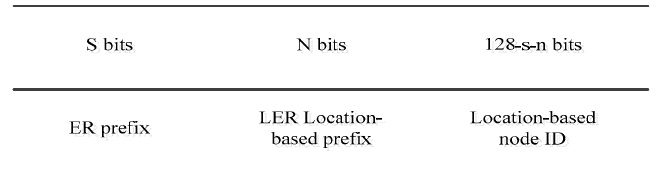
Figure 10. The IPv6 address structure with the location-based addressing (adapted from